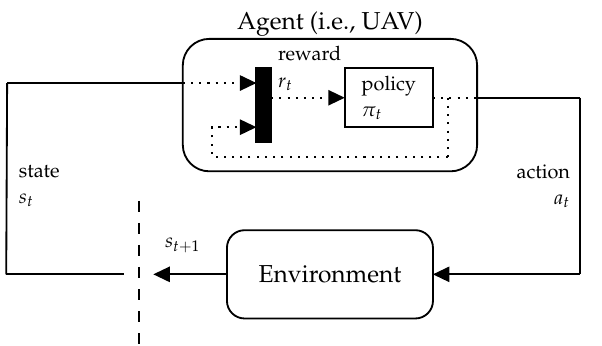
Figure 3. Interaction between the UAV (or agent) and the environment under the framework of Markov decision processes